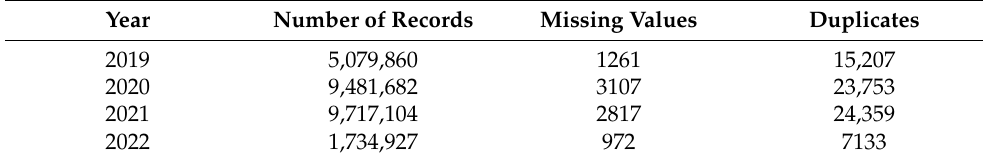
Table 3. Dataset record statistics.